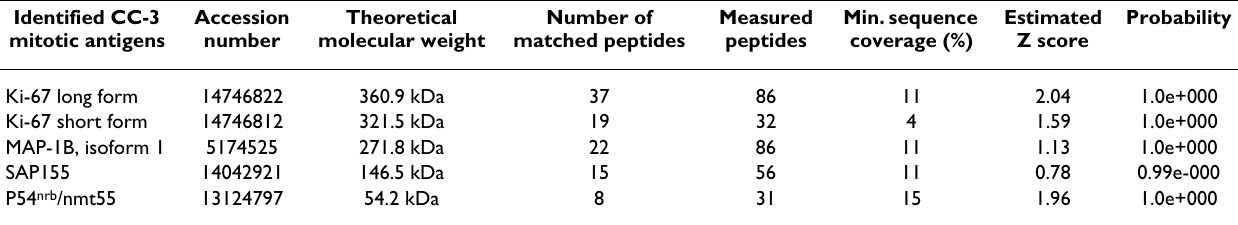
Table 1: Novel CC-3 mitotic antigens identified by MALDI-TOF-MS and ProFound research engine Identified CC-3 mitotic